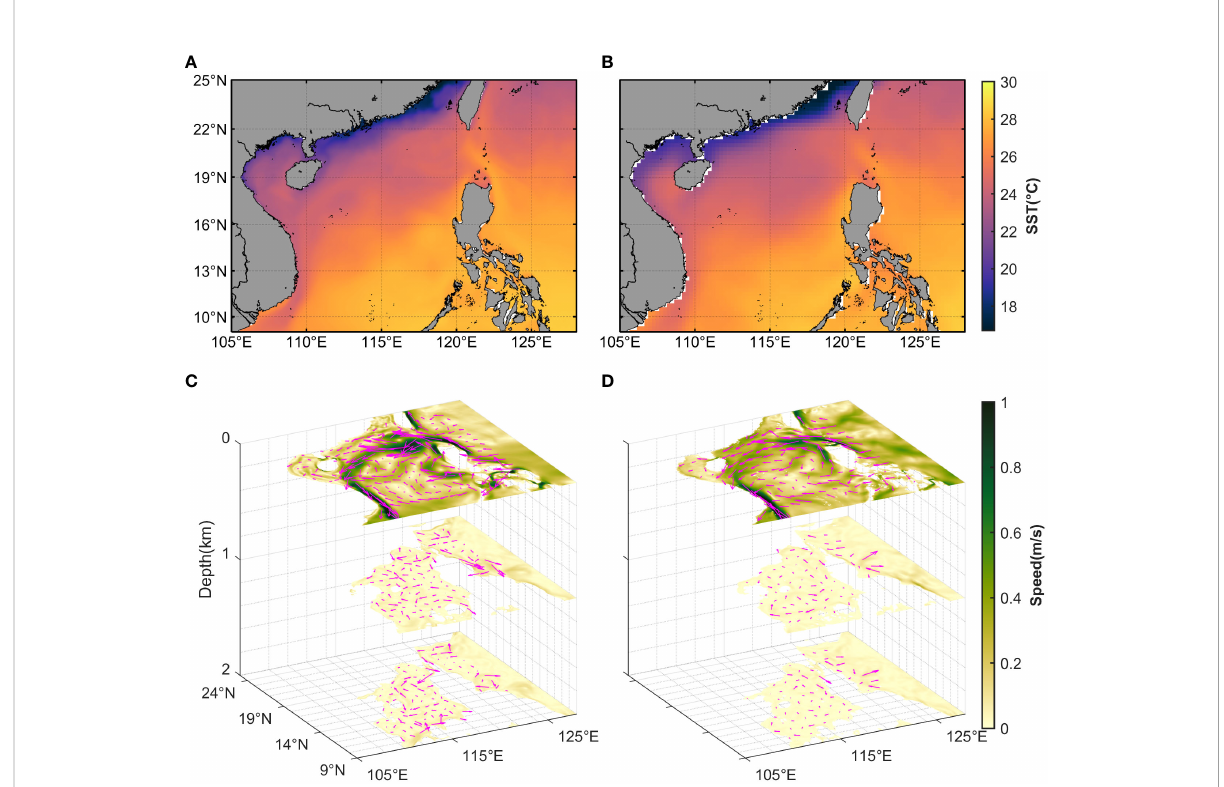
FIGURE 2 The monthly average SST in R5 of (A) the result of our model, (B) the OISST, and the monthly average circulation of 0m, 1000m and 2000m horizontal layers of (C) the result of our model, (D) the result of HYCOM reanalysis data. Both velocity arrows at 1000m depth and 2000m depth are magni fi ed by 5 times. The monthly average refers to the monthly average in January from 2017 to